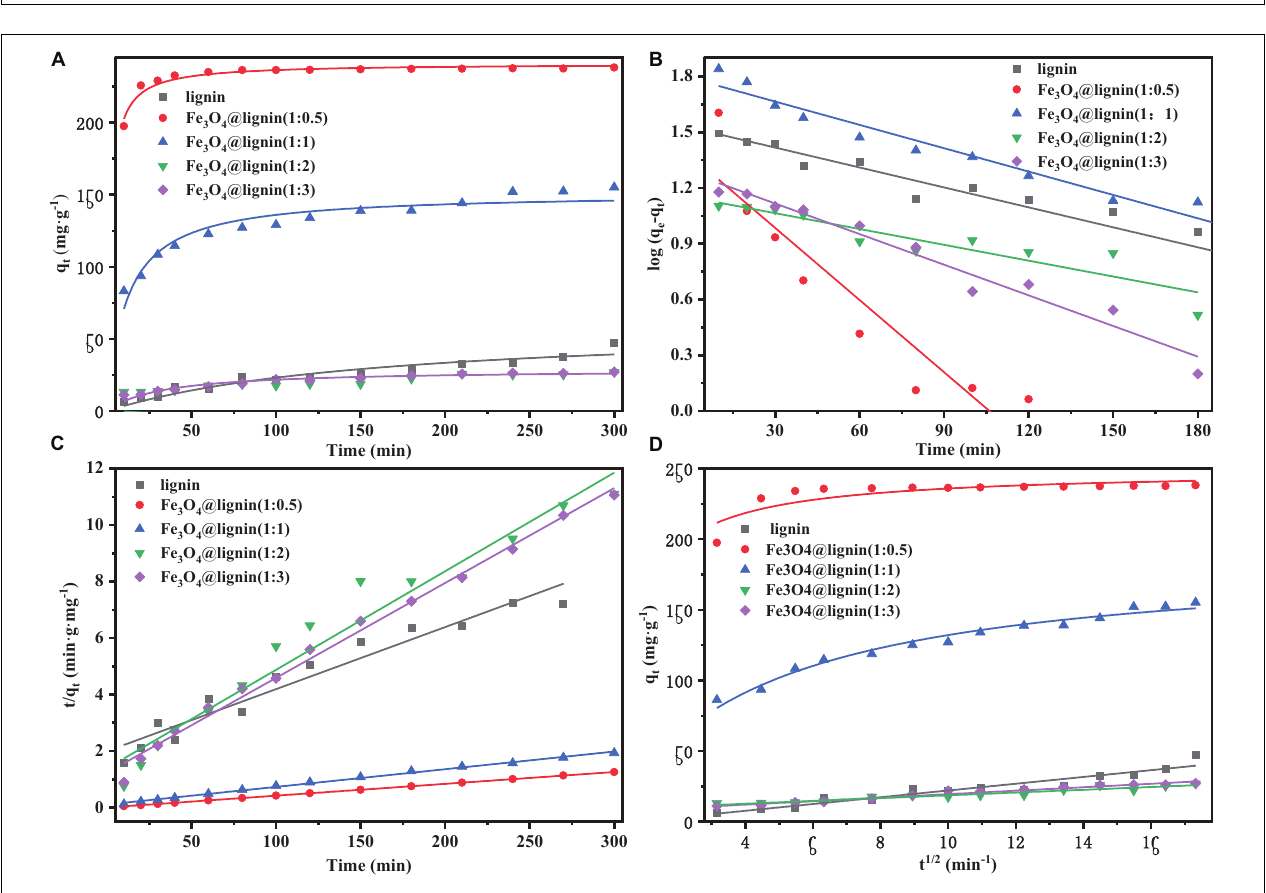
FIGURE 7 | (A) Effects of different adsorbents on Congo red adsorption at different times. (B) The pseudo-first-order kinetics model curve examined. (C) The pseudo-second-order kinetics model curve examined. (D) The intraparticle diffusion model.